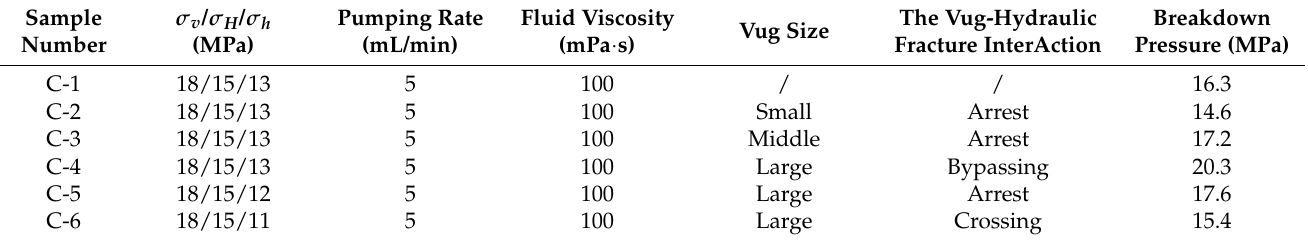
Table 1. Experimental parameters in laboratory hydraulic